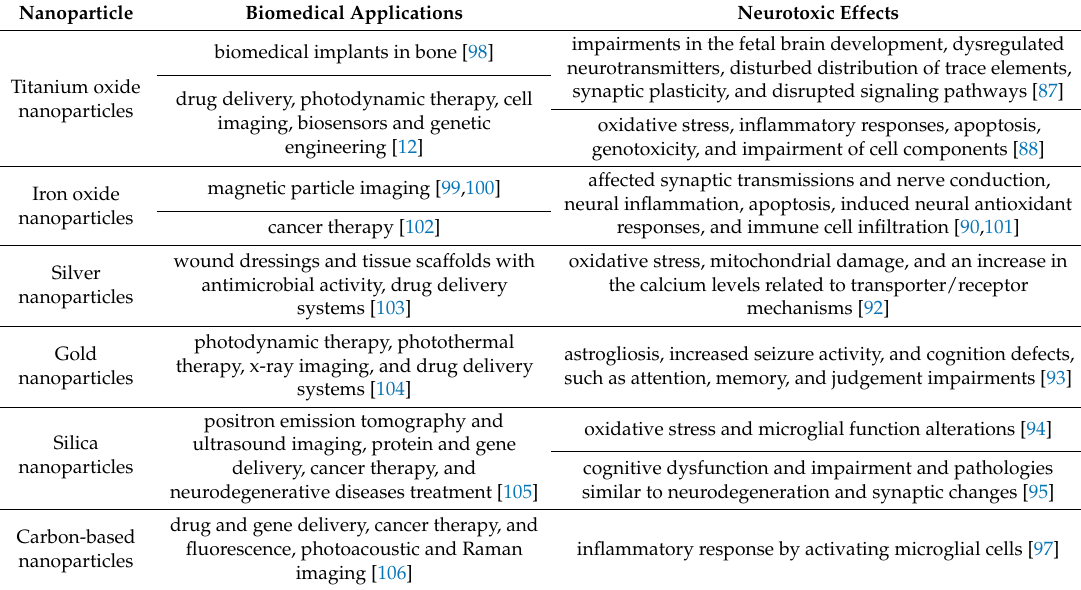
Table 1. Biomedical applications and the related neurotoxic effects of different